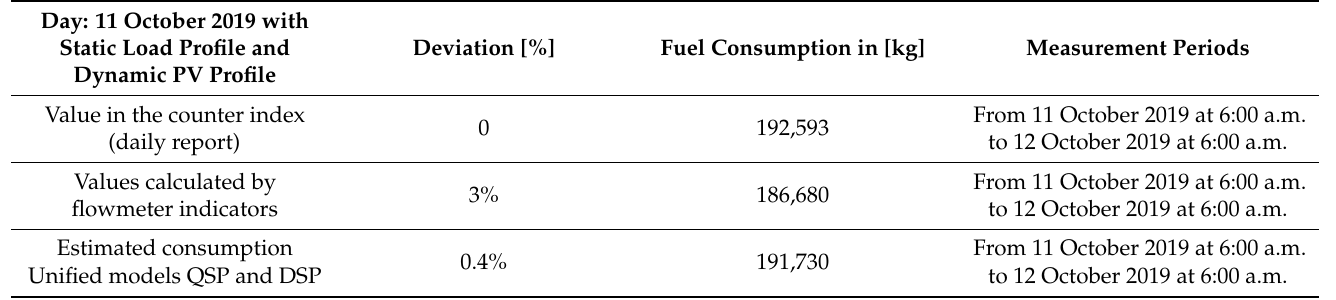
Table 5. Summary of fuel consumption mixed scenario QSP and DSP (Day: 11 October